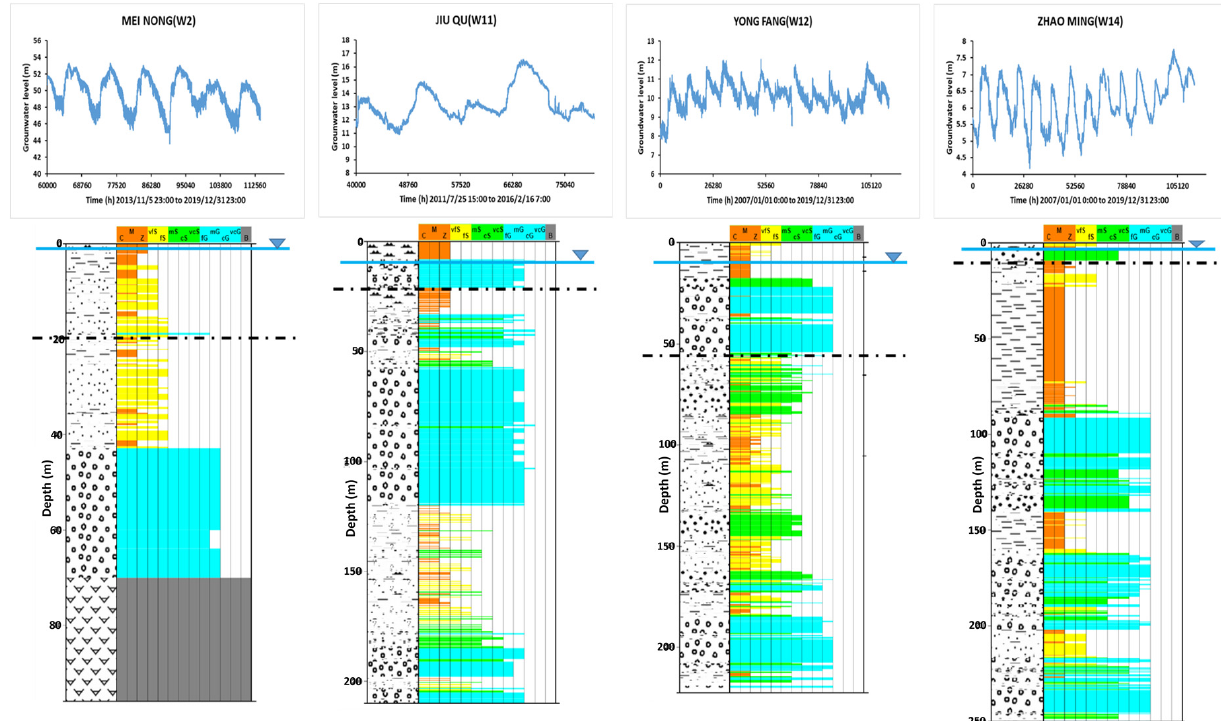
Figure 9. Confined aquifers verification with true hydrograph line thickness and lithology data. Confined aquifer nature is in Meinong, Jiuqu, Yongfang and Zhaoming observation wells. The black dotted line represents the bottom of layer 1 (shallow aquifer) while the blue line is the water table. CMZ represent clay, mud and silt; vfS and fS mean very fine sand and fine sand; mS, cS, vcS indicate medium sand, coarse sand and very coarse sand while fG, mG, cG, vcG are fine gravels, medium gravels, coarse gravels and very coarse